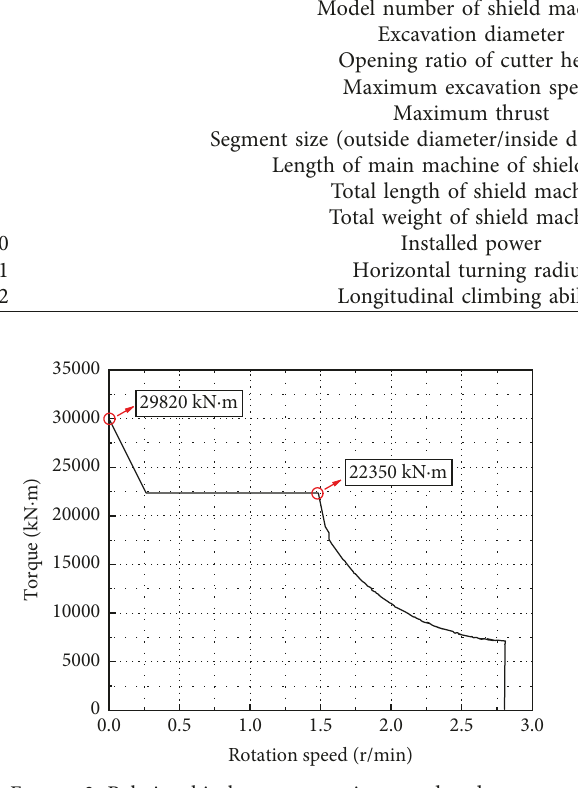
Figure 3: Relationship between rotation speed and